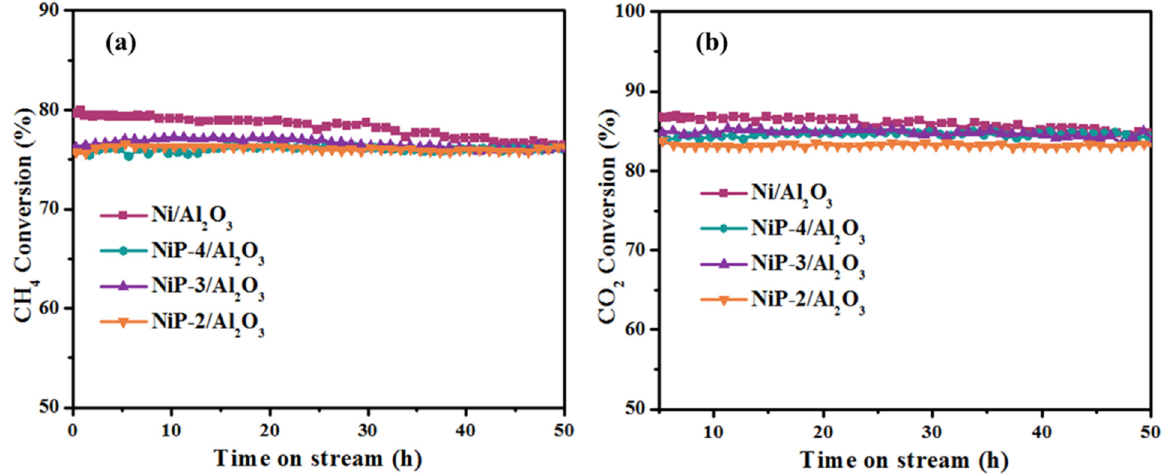
Figure 7. ( a ) CH 4 and ( b ) CO 2 conversion as a function of time on stream over Ni/Al 2 O 3 and NiP- x/Al 2 O 3 catalysts.